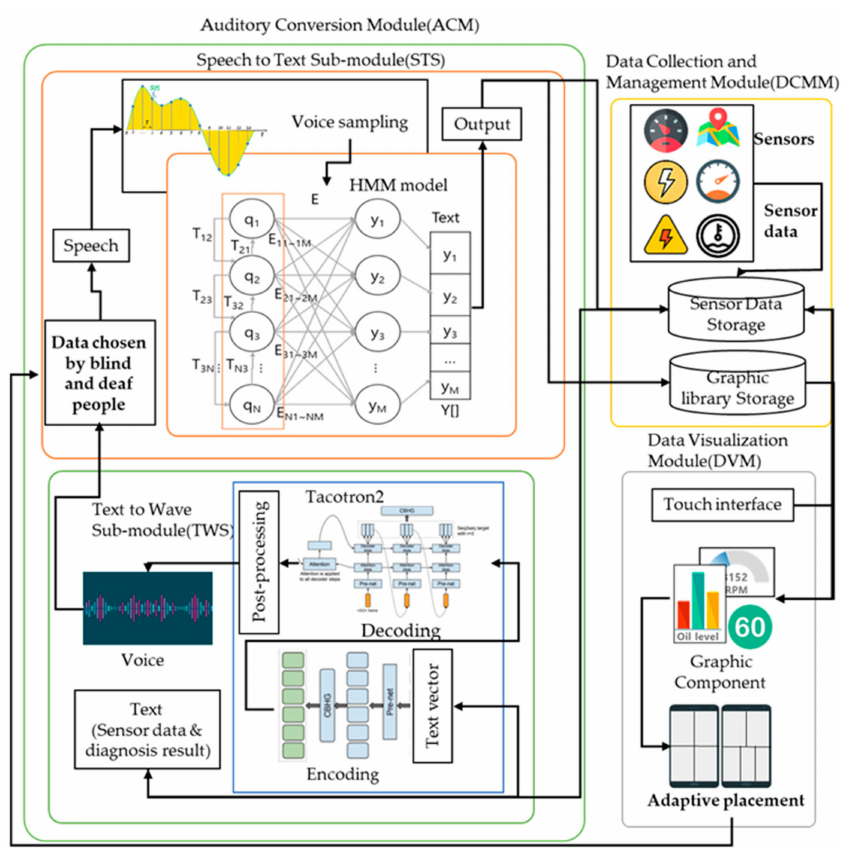
Figure 1. Structure of the system. HMM: hidden Markov